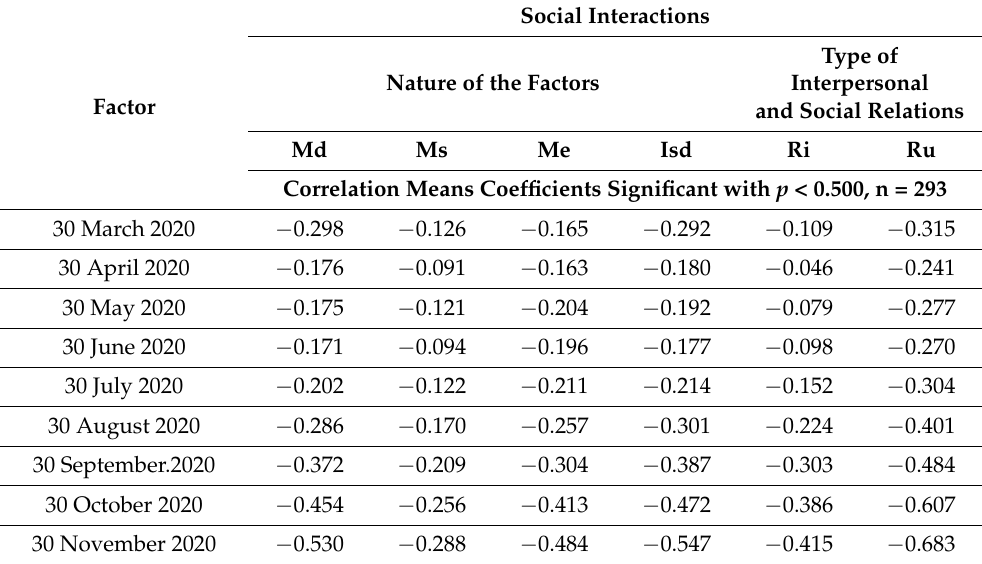
Table 2. Social interactions according to nature of factors and type of relations (Pearson’s correlation). Social Interactions Type of Nature of the Factors Interpersonal Factor and Social Relations Md Ms Me Isd Ri Ru Correlation Means Coefficients Significant with p < 0.500, n = 293